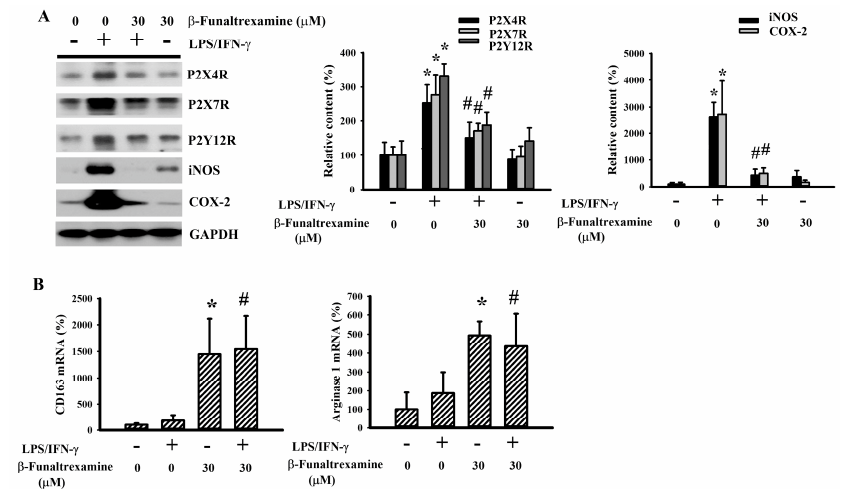
Figure 3. β -funaltrexamine alleviated microglial activation. Neuron / glia cultures were pretreated with vehicle or β -funaltrexamine (30 µ M) for 30 min before being incubated with LPS (100 ng / mL) / IFN- γ (10 U / mL) for an additional 24 h. ( A ) Total cellular proteins were extracted and subjected to Western blot analysis with indicated antibodies. One representative blot of four independent culture batches is shown. ( B ) Total cellular RNAs were extracted and subjected to quantitative RT-PCR for the measurement of CD163 and arginase 1 mRNA expression. * p < 0.05 vs. untreated control and # p < 0.05 vs. LPS / IFN- γ control, n = 4. Int. J. Mol. Sci. 2020 , 21 , x FOR PEER REVIEW